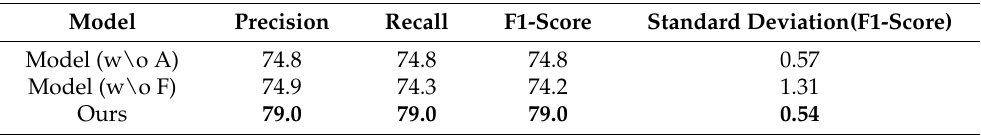
Table 6. Ablation experiment results. w\o means removing this component. A represents the data enhancement method, and F represents the feature fusion strategy. Model Precision Recall